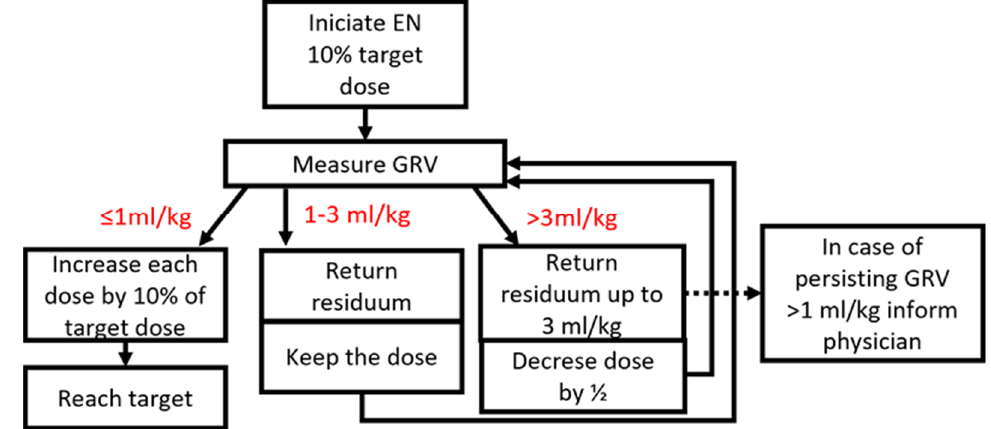
Figure 1. Example of a stepwise approach to enteral nutrition.